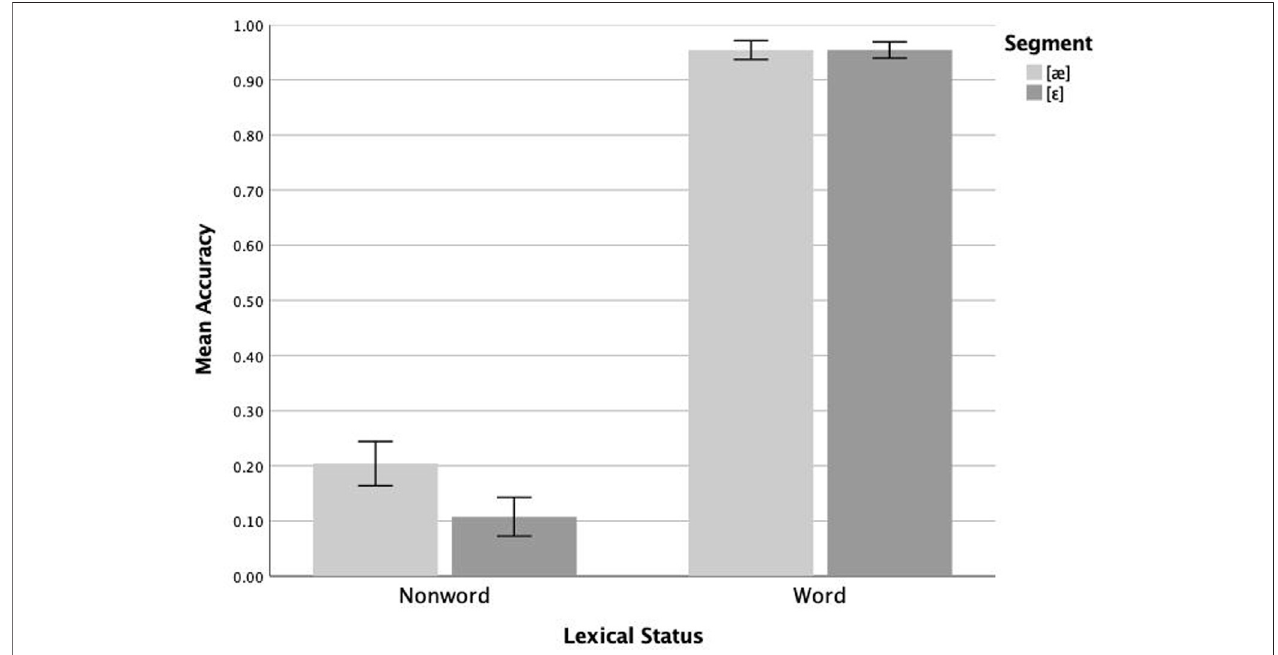
FIGURE 6 | Mean lexical decision accuracy (proportion correct) on [l] and [ ɹ ] items by native Korean speakers ( n (cid:1) 24). Whiskers represent 1 SE.